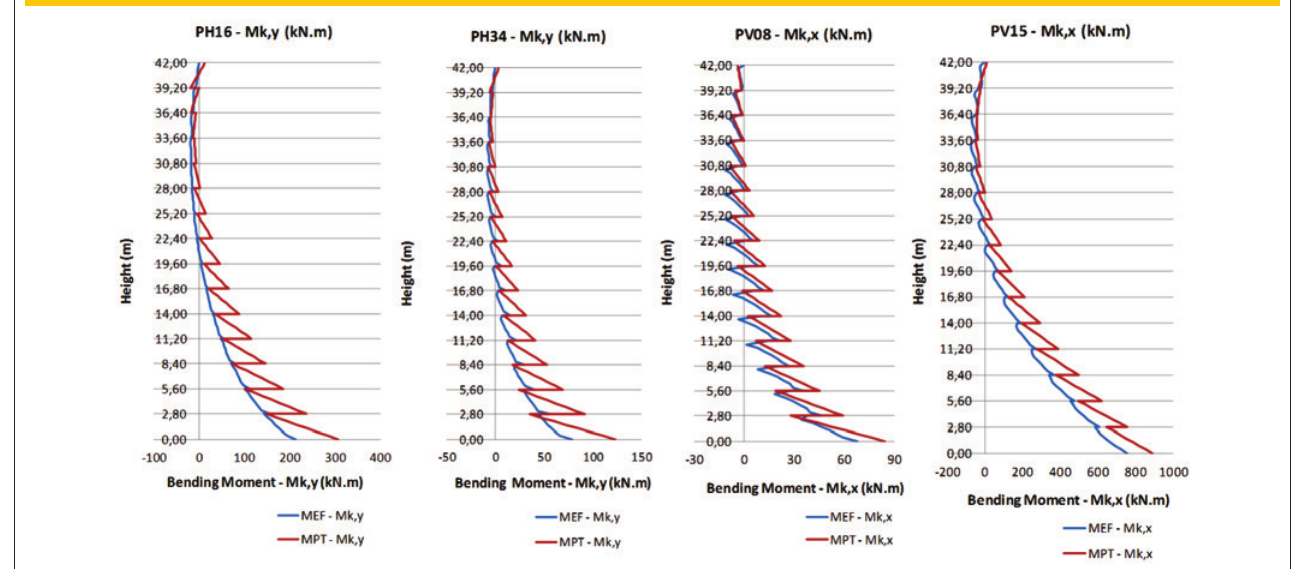
Figure 12 – Diagram of M of the walls PH16 and PH34 and M of the walls PV08 and PV15